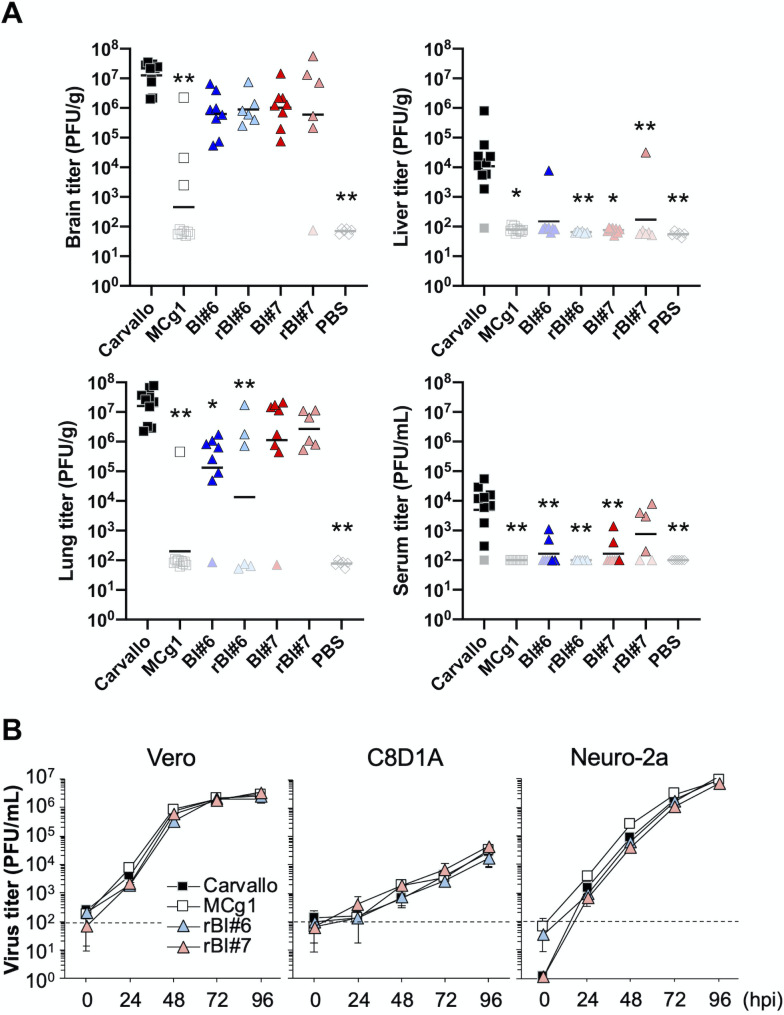
Virus dissemination and the growth curves of the revertants.(A) Virus titers in brain, lung, liver and serum. Each dot indicates an individual mouse. Samples under the detection limit were plotted with their detection limits in whitish color. The solid bar represents the geometric mean of the titers. Statistically significant differences compared with Carvallo are indicated by asterisks (*, P<0.05 and **, P<0.01 by Dunn’s post-test after Kruskal-Wallis test). (B) Virus growth of the revertants was characterized in African green monkey kidney-derived Vero cell, murine astrocyte-derived C8D1A cells and murine neuroblastoma-derived Neuro-2a cells (MOI = 0.01). The dashed line indicates the detection limit. Data shown are averages of triplicate wells with error bars indicating the SD.